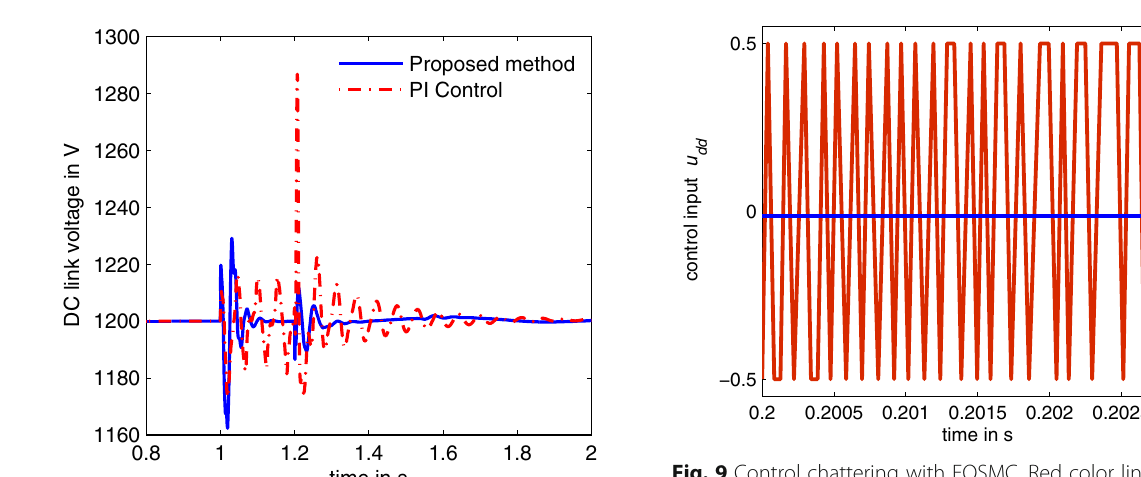
Fig. 9 Control chattering with FOSMC. Red color line indicates FOSMC and the blue one indicates the proposed method